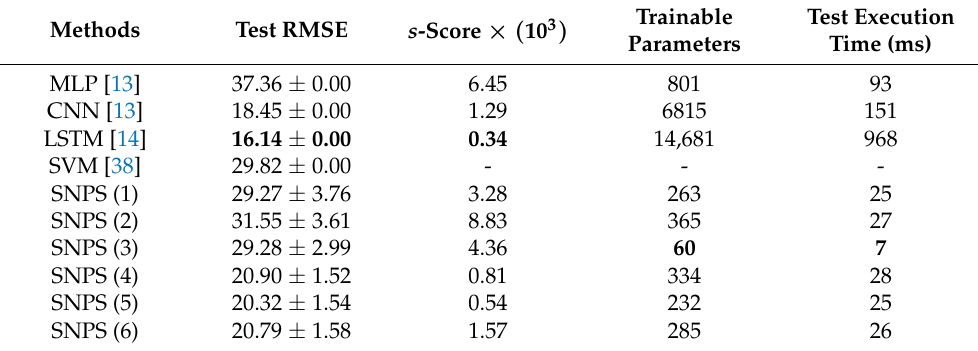
Table 7. Summary of the comparative analysis based on the test results on CMAPSS (FD001). The symbol “-” indicates not available data. For our SNPS methods, we report the RMSE in terms of mean ± std. dev. across 10 independent runs. For the remaining methods, we report the results from the original papers (std. dev. not provided). The boldface indicates the best value per